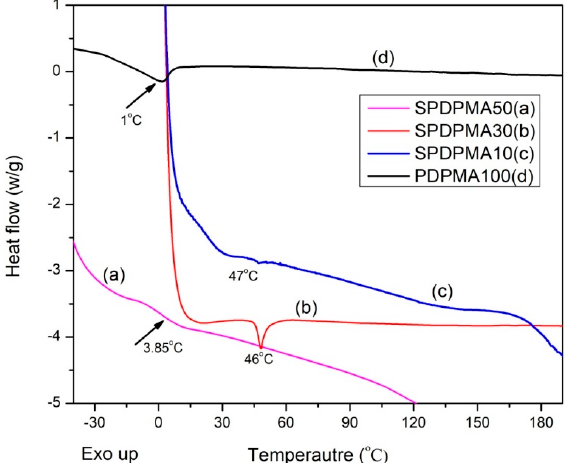
Figure 5. DSC curves of Styrene- PDPMA copolymers synthesized via one pot ATRP copolymerization (The T g of poly (PDPMA) was = 1 °C [30] and poly (styrene) = 106 °C).